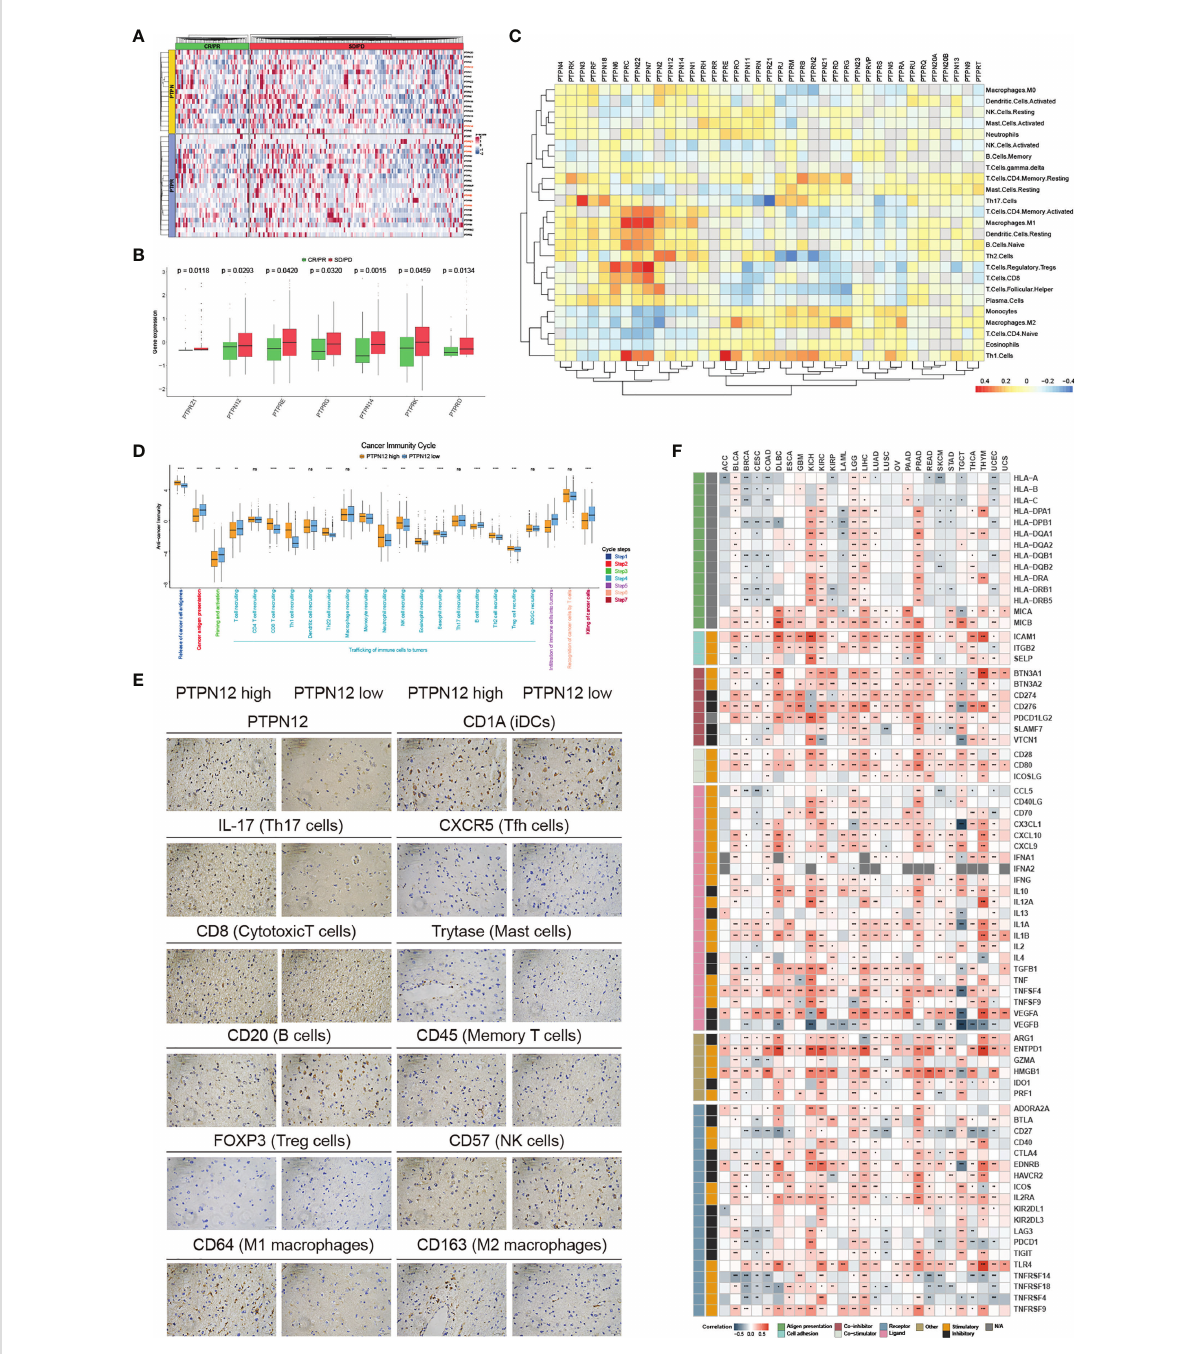
FIGURE 5 Immunological characteristics of classical PTPs in the TME. (A) Relative expression of classical PTPs in the responder (green) and the non- responder (red) subsets. (B) Signi fi cantly different PTPs between the responder and the non-responder subsets. (C) Correlation between classical PTPs and immune cell in fi ltration. (D) Deviations for the cancer immunity cycle between the high- and low-PTPN12 groups in glioma. (E) Representative IHC images of in fi ltrated immune cells in glioma. (F) Correlation between PTPN12 and 129 immunomodulators. *P < 0.05, **P < 0.01, ***P < 0.0001, ****P < 0.00001. ns indicates not signi fi